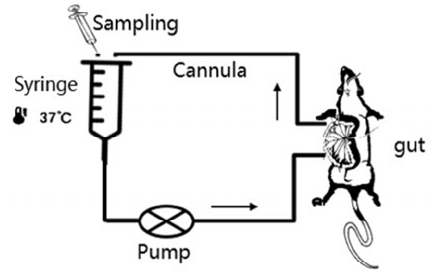
Figure 1. Recirculation method in a rat model.